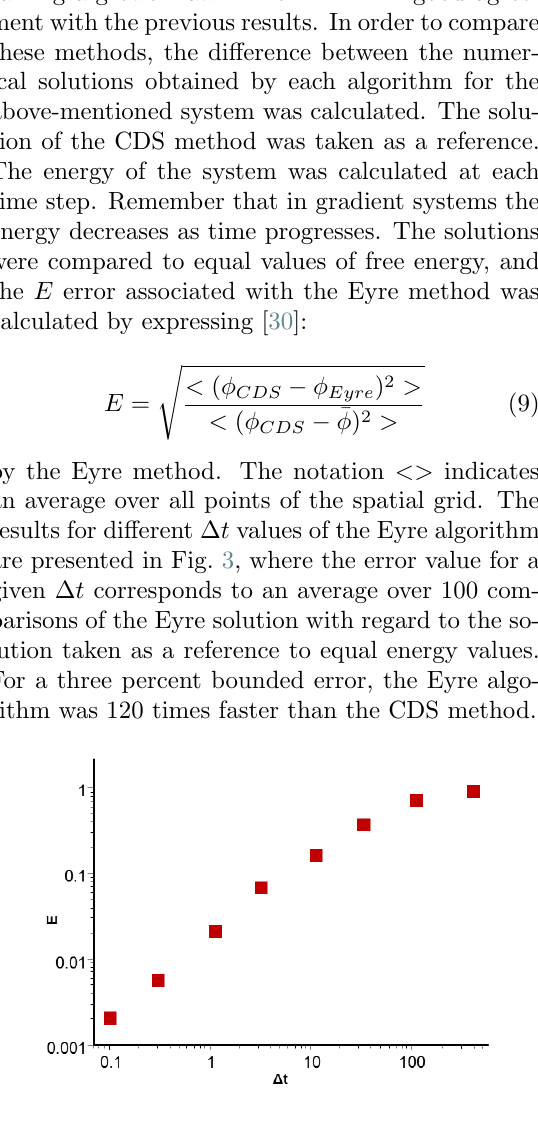
Figure 3: Calculation of the error E associated with the simulations performed for different ∆ t time dis- cretizations, compared with the CDS system used as a reference according to equation 9. The plotted values correspond to an average over 100